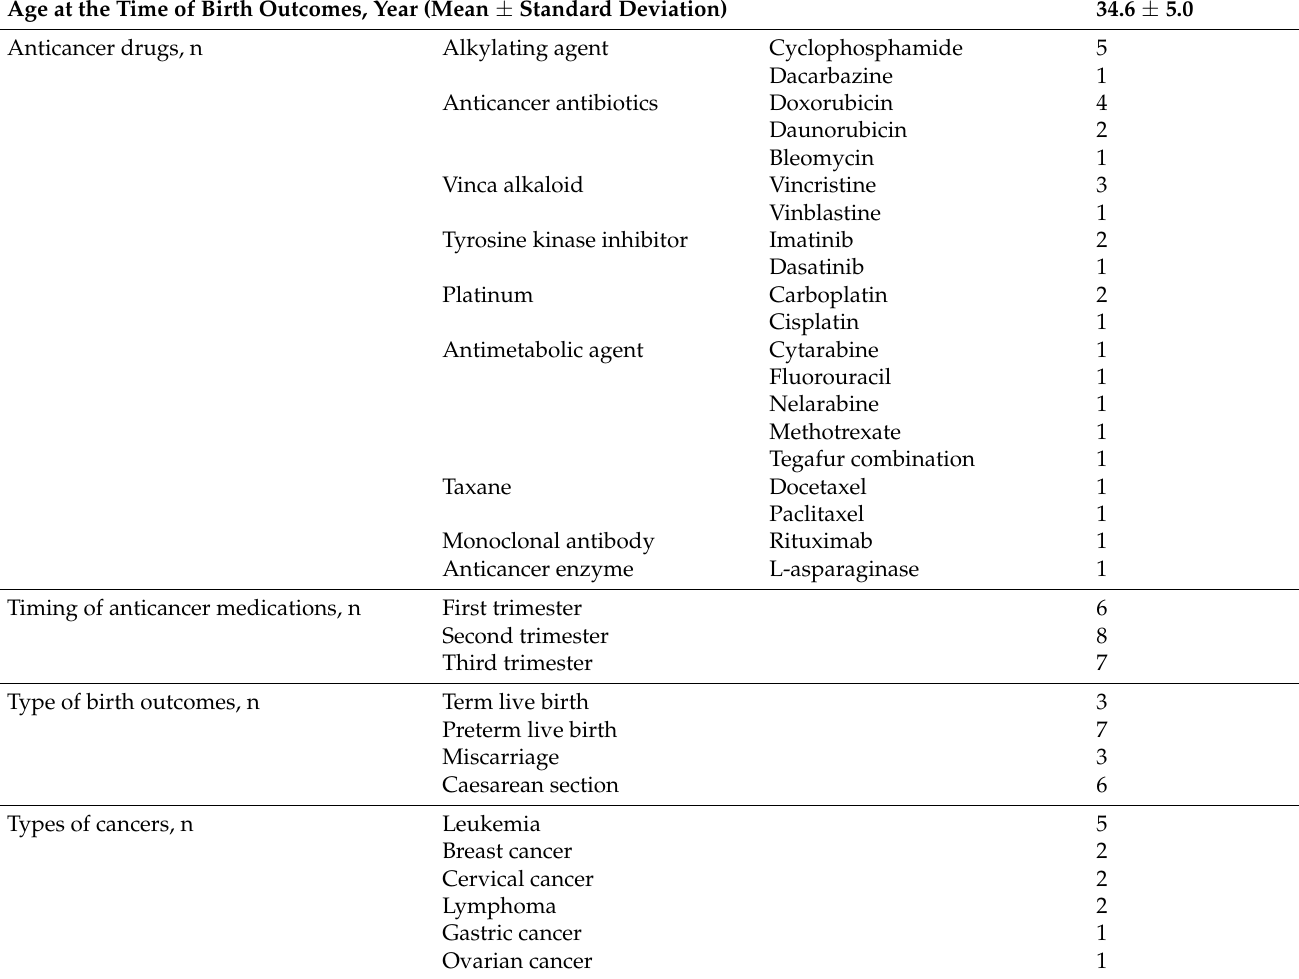
Table 1. Characteristics of study population ( n =